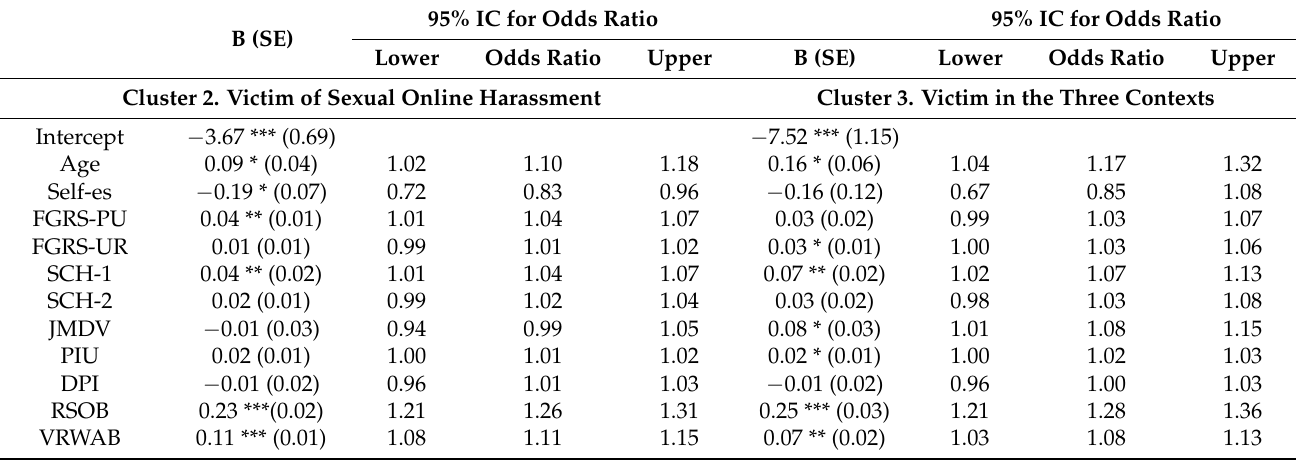
Table 5. Multinomial logistic regression with cluster membership as dependent